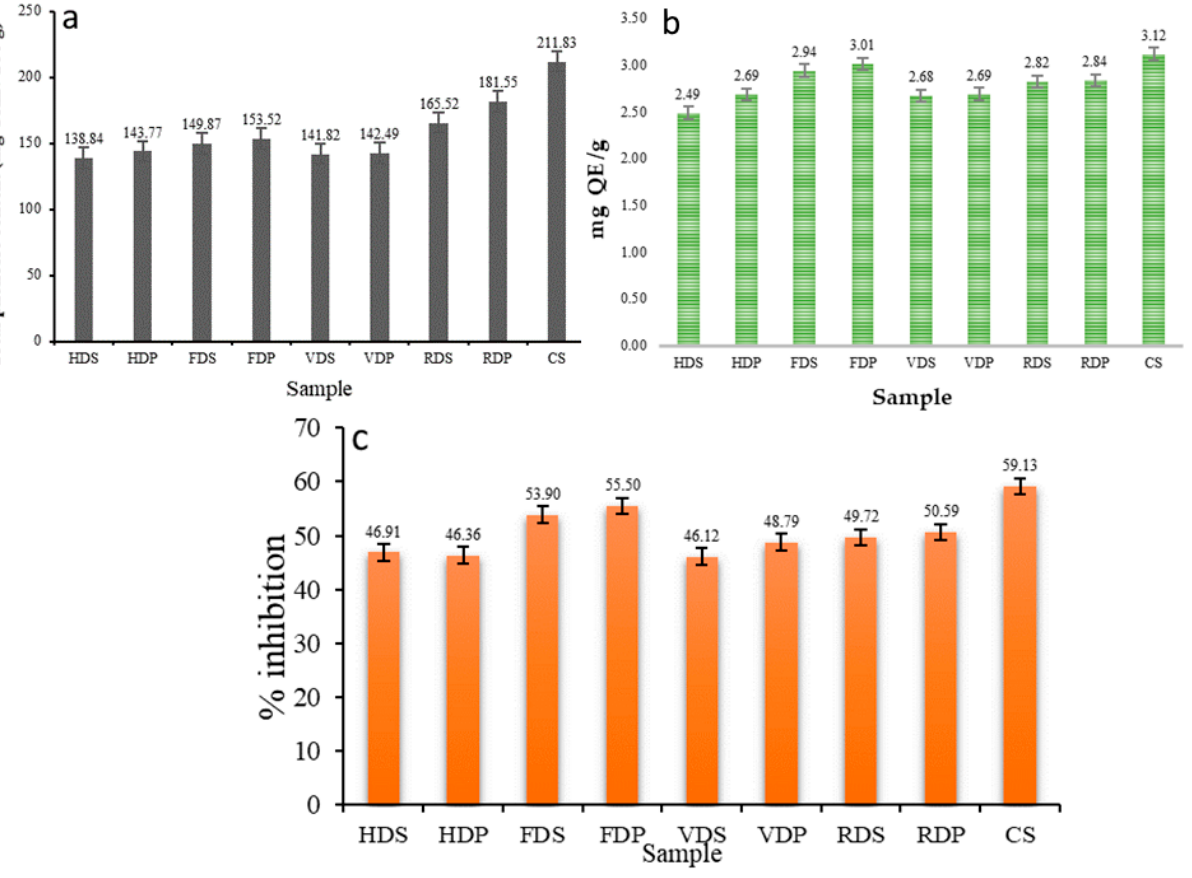
Figure 4. Total phenolic content ( a ), total flavonoid content ( b ), and antioxidant activity ( c ) of dragon fruit samples. For sample codes, refer to Figure